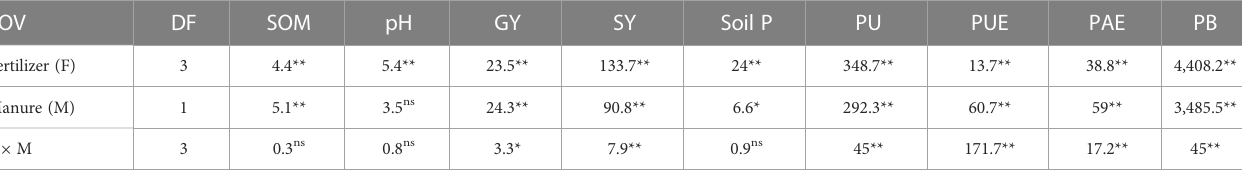
TABLE 4 Field study: Statistics (F-Values with P-value signi fi cance indicated) for soil properties, yields, and P ef fi ciency. SOV DF SOM pH GY SY Soil P